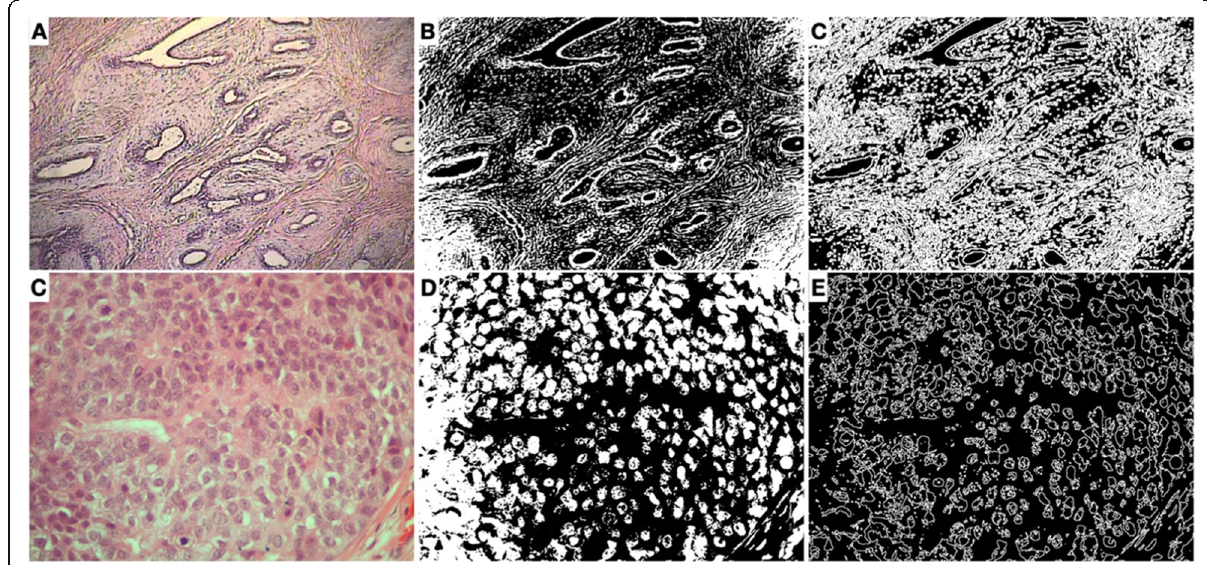
Fig. 2 Analysis protocol with a representative image from the BACH set. a Benign slide from BreakHis set (40X); b Binarized image (40X); c Edge detection (40X); d-f Depict the protocol applied to a higher magnification image,